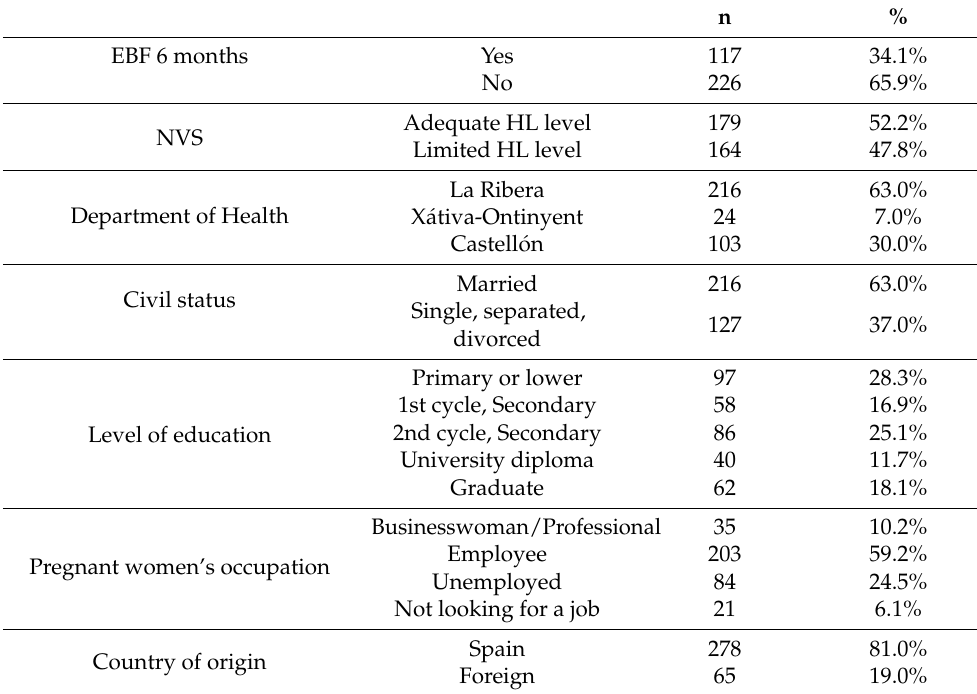
Table 1. Characteristics of the included females (n =